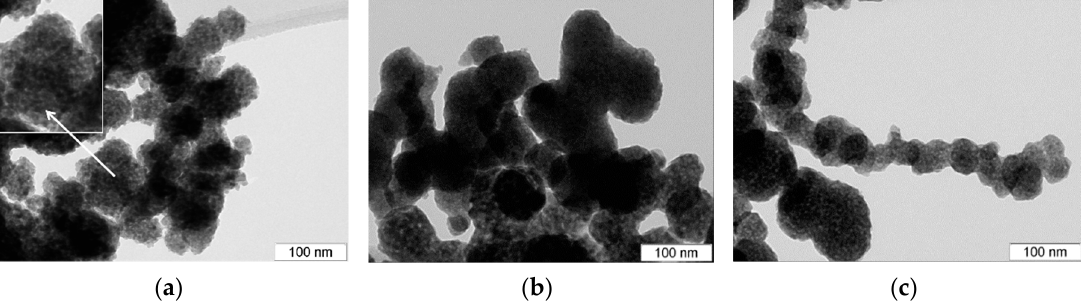
Figure 4. TEM images of Ce 0.3 Zr 0.7 support (a) , Ni-Ce 0.3 Zr 0.7 im (b), and Ni-Ce 0.3 Zr 0.7 op (c) catalysts.